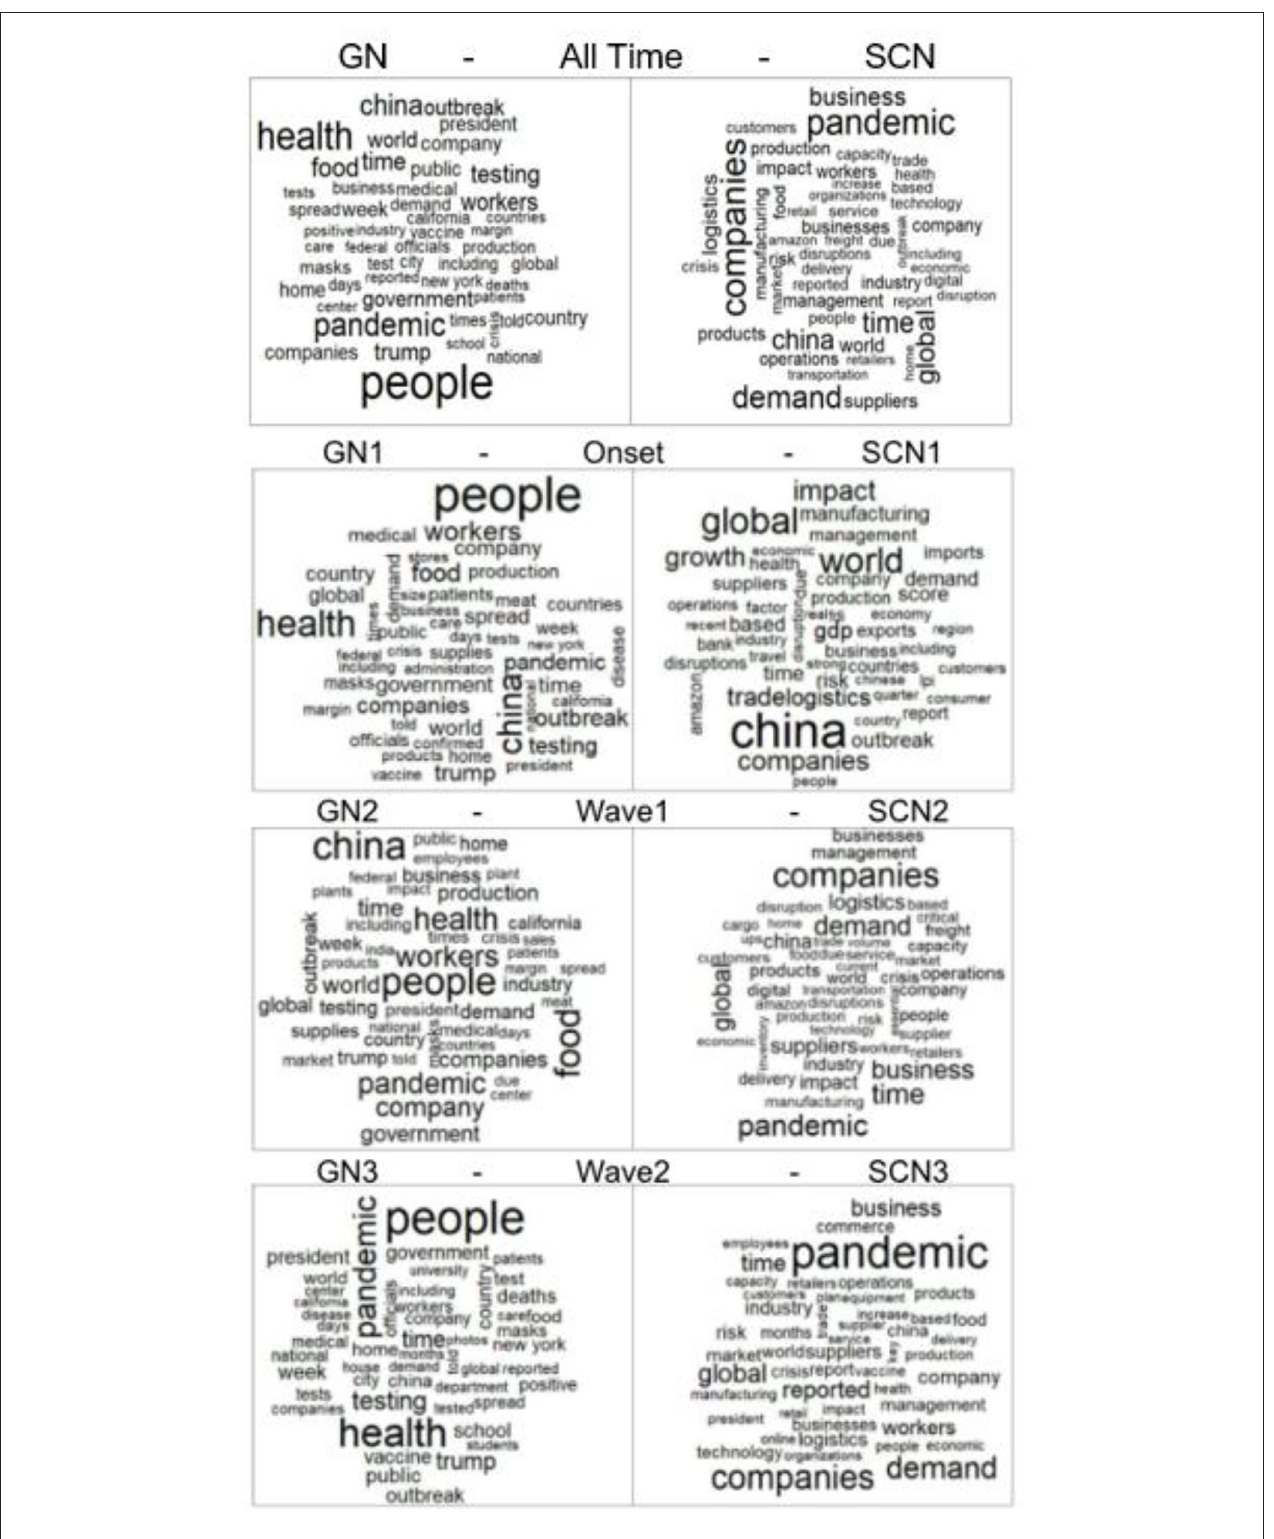
FIGURE 2 | Comparing word clouds for GN (left) and SCN (right) across the three phases.